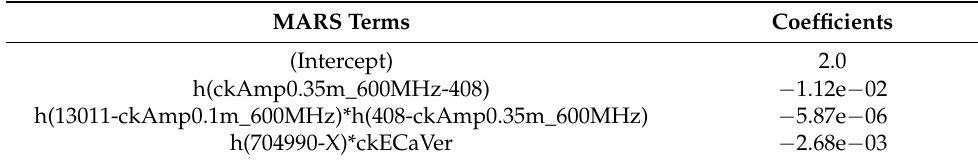
Table 10. MARS model structure.